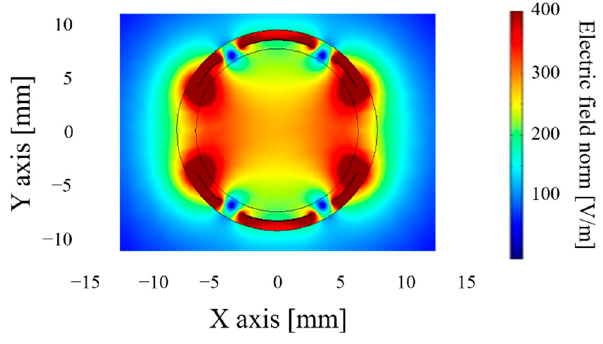
Figure 13. Electric field density around the sensor with branches.